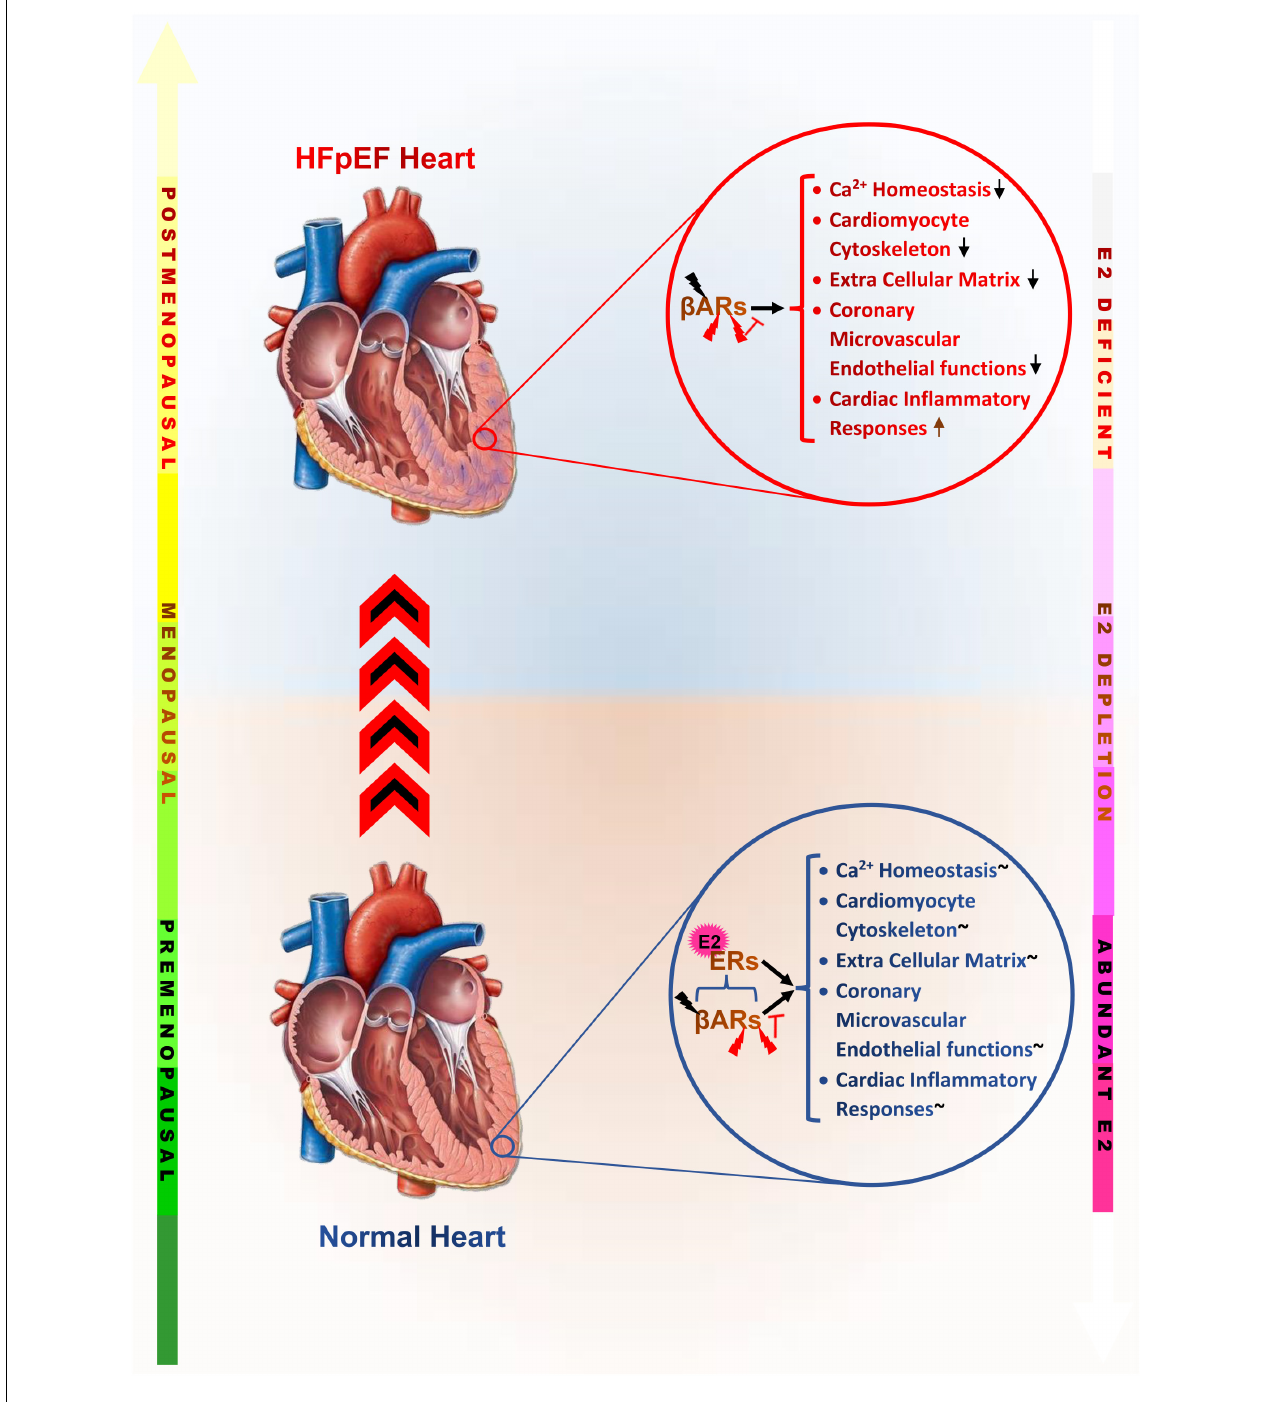
FIGURE 3 | Graphical abstract of the underlying maladaptive alterations scaffolded by estrogen deficiency, which increase the incidence of heart failure with preserved ejection fraction in postmenopausal women. β ARs, β -adrenergic receptors; ERs, Estrogen receptors; , Physiological levels of catecholamine; , Pathological levels catecholamine; , inhibition; , Adaptively modulated; E2, Estrogen; , Disrupted/dysregulated; , Upregulated maladaptively.